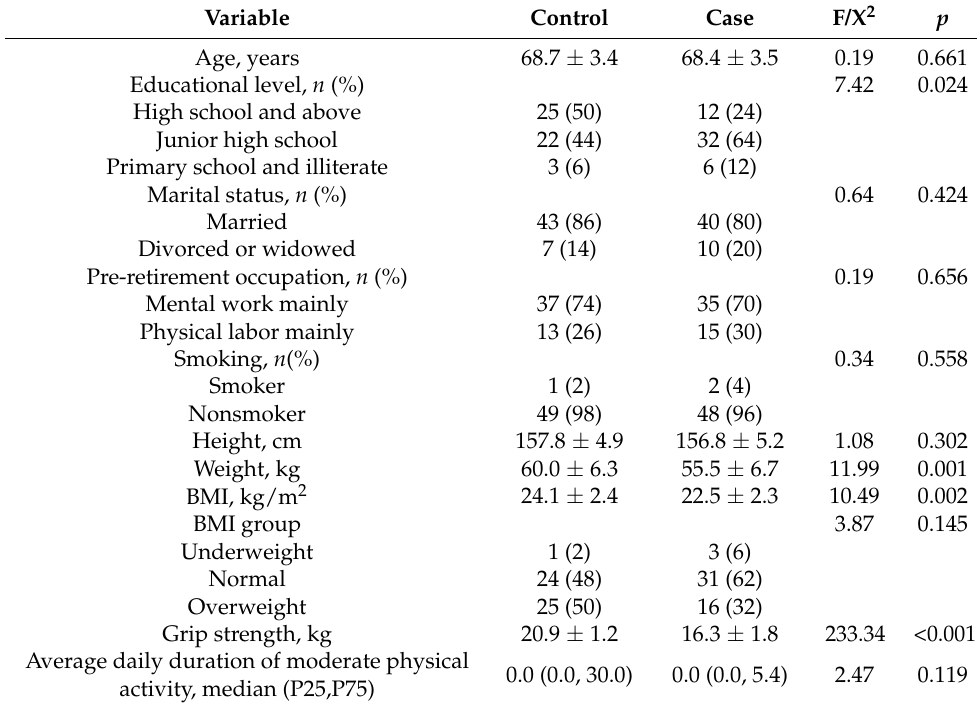
Table 1. Basic characteristics of study participants in each